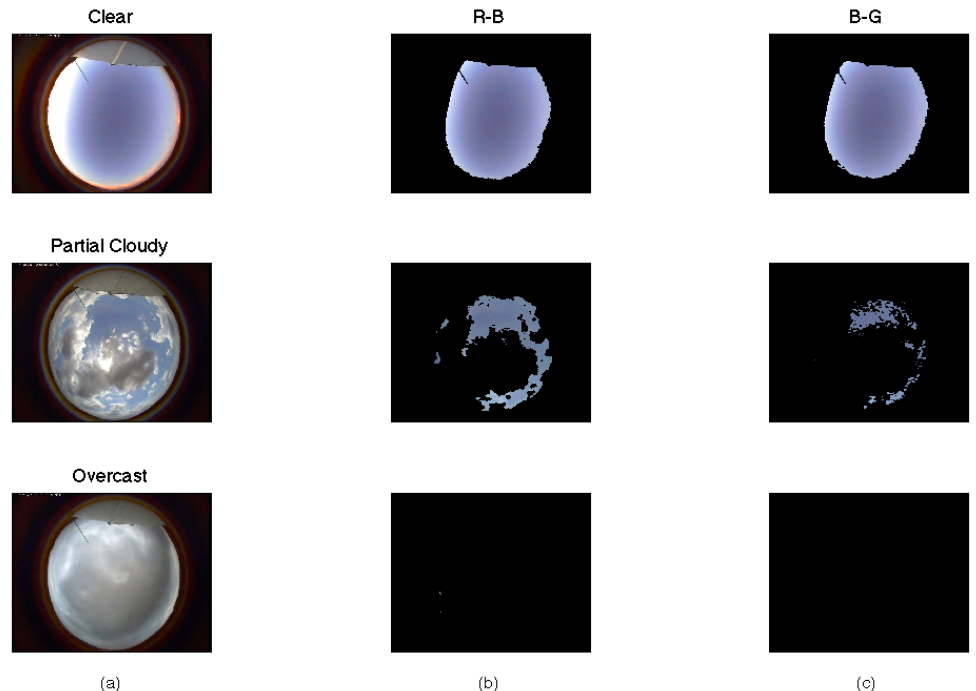
Figure 5. ( a ) The all-sky images of three sky conditions (clear, partially cloudy and overcast) while their R-B and B-G Color Difference outcomes are shown in ( b , c ), respectively.